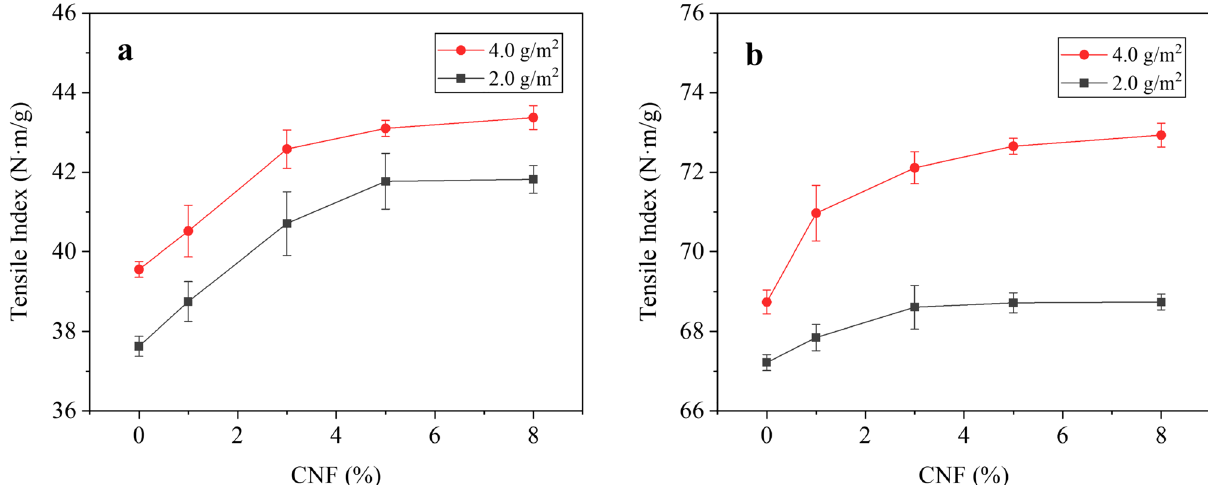
Figure 10. Effect of CNF dosage on ( a ) transverse and ( b ) longitudinal tensile strength of paper.